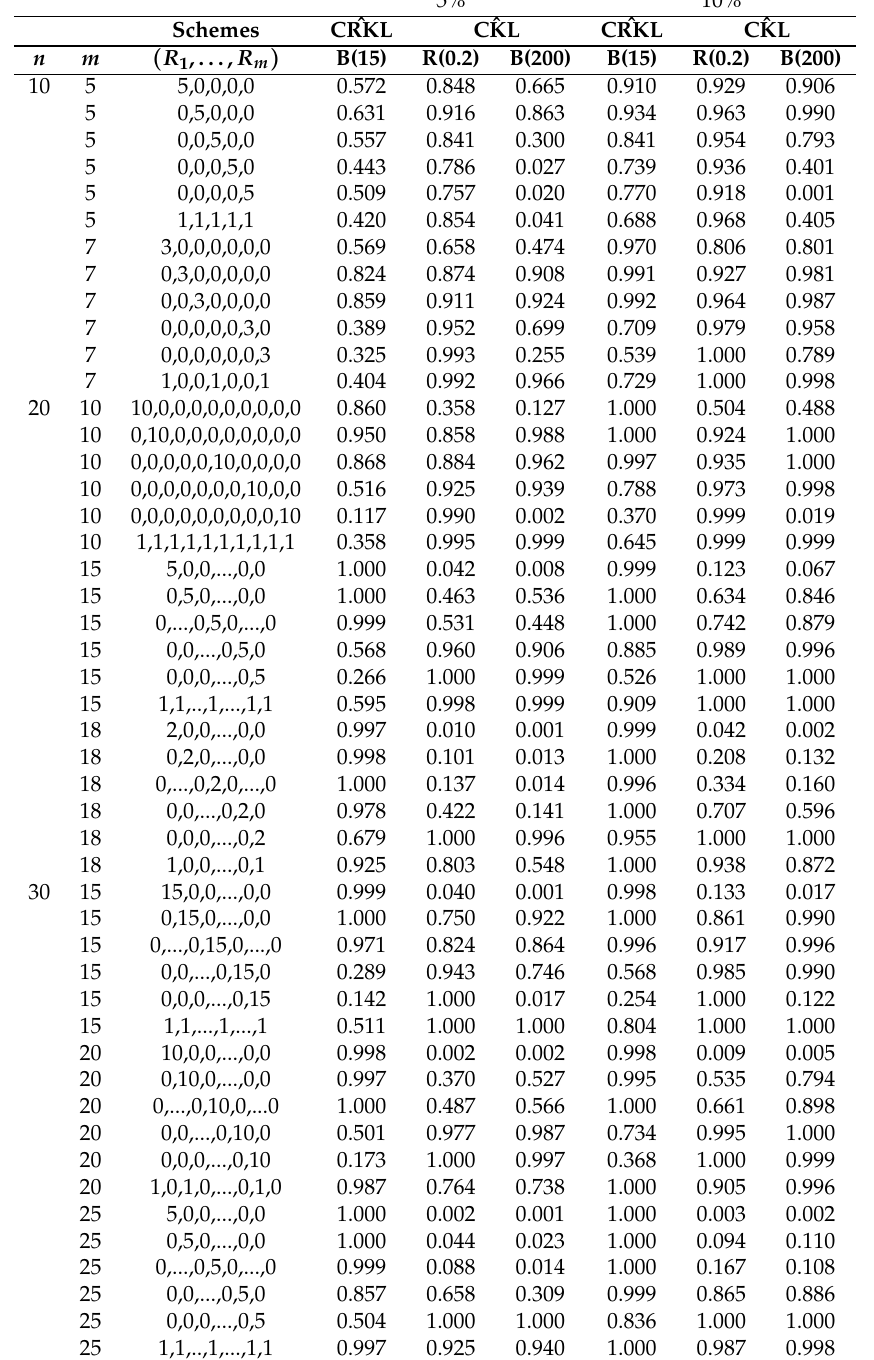
Table 4. Powers for the monotone increasing hazard at the 5% and 10% significance levels for the different censorship schemes in the case of sample sizes n = 10, 20, and